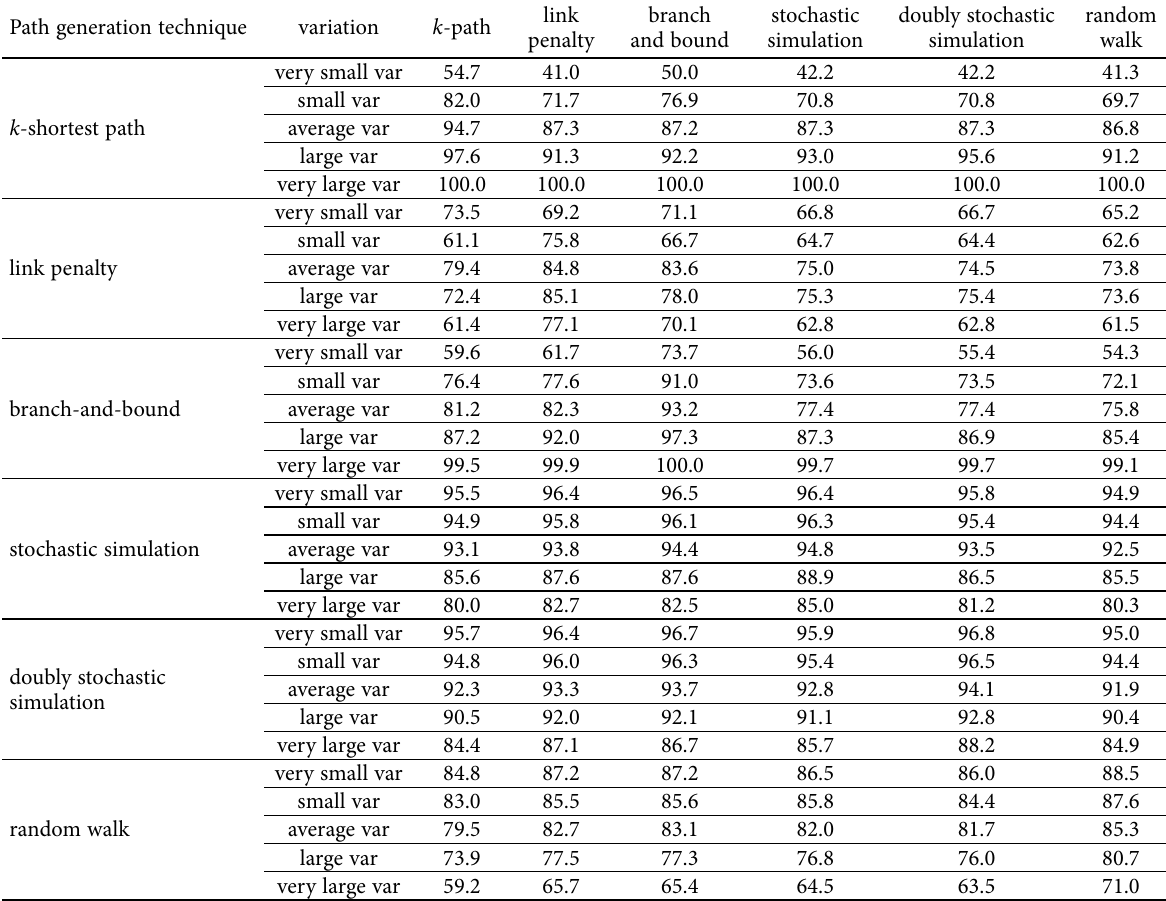
Table 3. Coverage of objective choice sets with respect to ‘postulated chosen